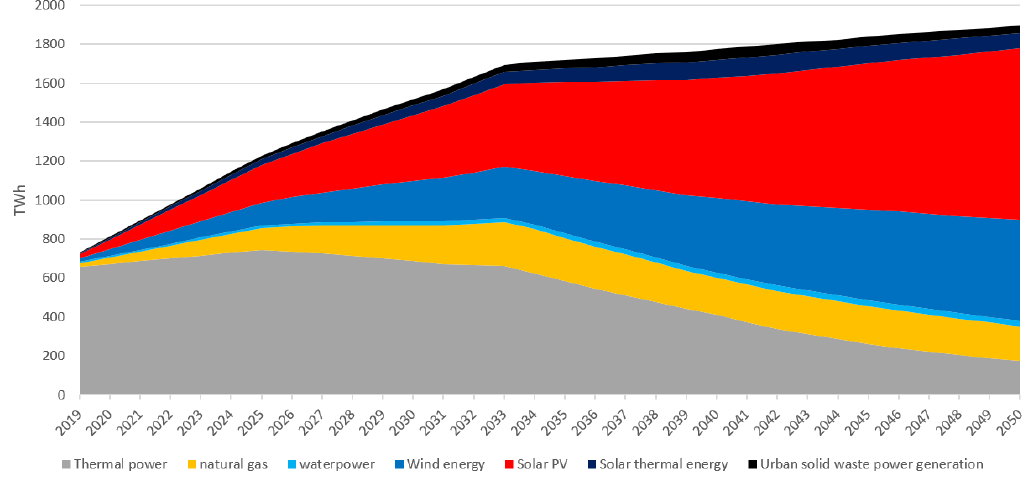
Figure 18. Power generation change in Inner Mongolia under the scenario of early retirement of coal power units.